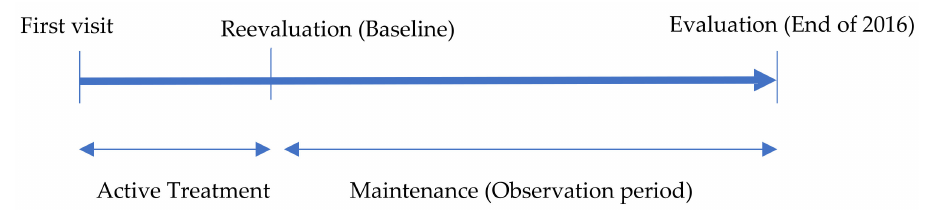
Figure 1. Time table of active treatment and